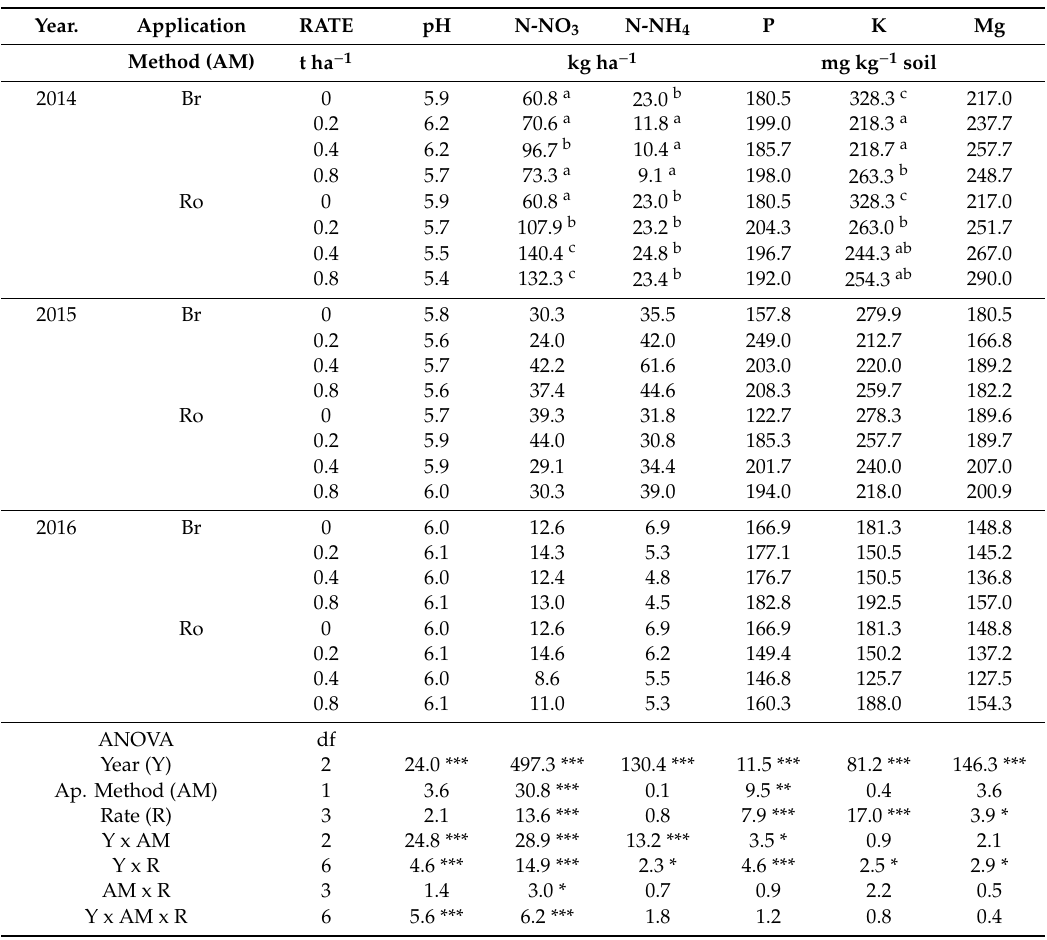
Table 4. E ff ect of digestate application method and rate on soil pH, content of inorganic nitrogen, and plant-available